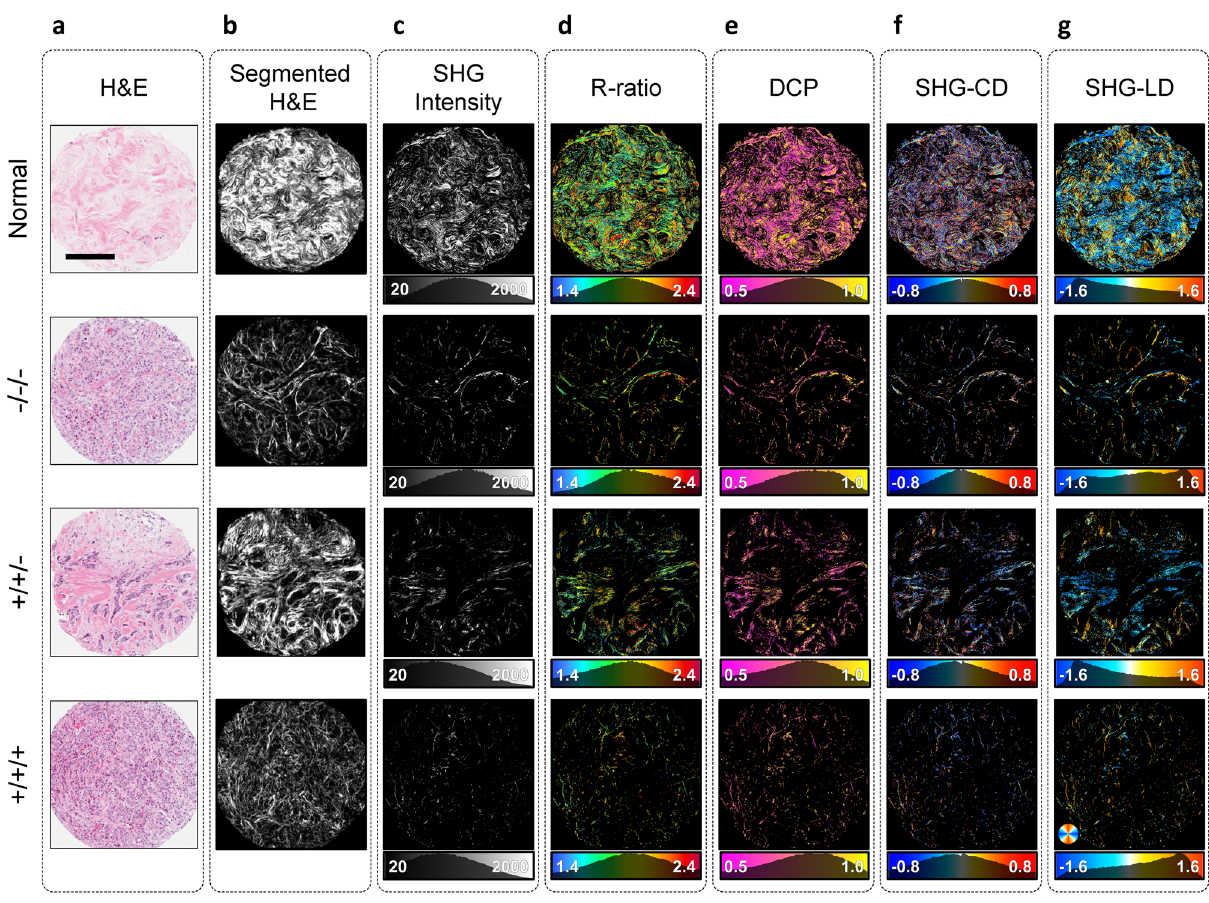
Figure 3. Widefield P-SHG polarimetric parameters. ( a ) Representative H&E white light images of normal and three tumor breast cores with different expressions of the receptors ER/PR/HER2. Scale bar: 200 µ m . ( b ) Segmented images display the portion of H&E images stained by Eosin, which serves as a good estimate for total collagen content of the tissue. ( c ) SHG intensity of circularly-polarized incident light, highlighting ordered collagen fibers. Normal core produces much larger SHG signal. ( d ) R-ratio images of cores range from 1.4 to 2.4, indicating the presence of collagen in the tissue. ( e ) Degree of circular polarization images show larger means in tumor due to higher R-ratio and low depolarization. ( f – g ) SHG-CD and SHG-LD images depict the out- of-plane and in-plane fiber orientations, respectively. Due to unbiased sectioning of the tissue, collagen fibers are at random orientations, resulting in SHG-CD distributions centered around zero, and SHG-LD distributed